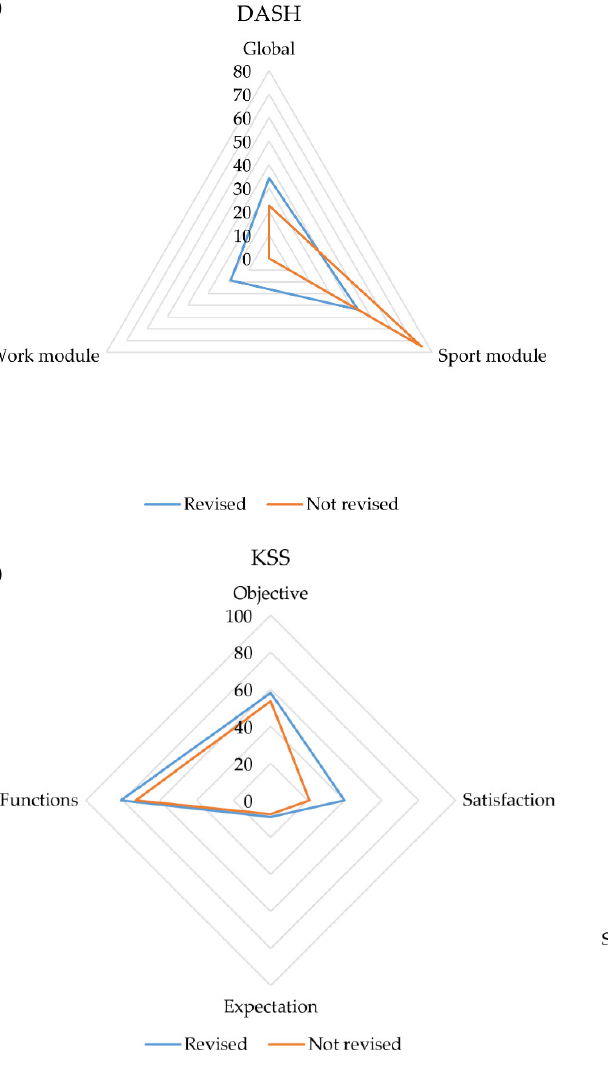
Figure 2. Functional outcome measures and PROMs of the study cohort. ( a ) Depicts the DASH, ( b ) the FAOS, ( c ) the KSS, and ( d ) the SF-36. Abbreviations: PROM: Patient-reported outcome measure, DASH: Disabilities of the Arm, Shoulder, and Hand Score, KSS: Knee Society Score, FAOS: Foot and Ankle Outcome Score, SF-36: Short-form Health Survey 36-item